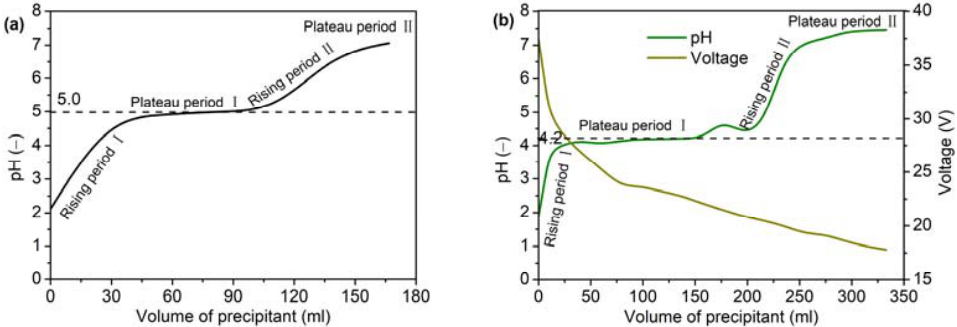
Figure 3. Change in pH and voltage with precipitant volume: ( a ) without electric field and ( b ) with electric field.